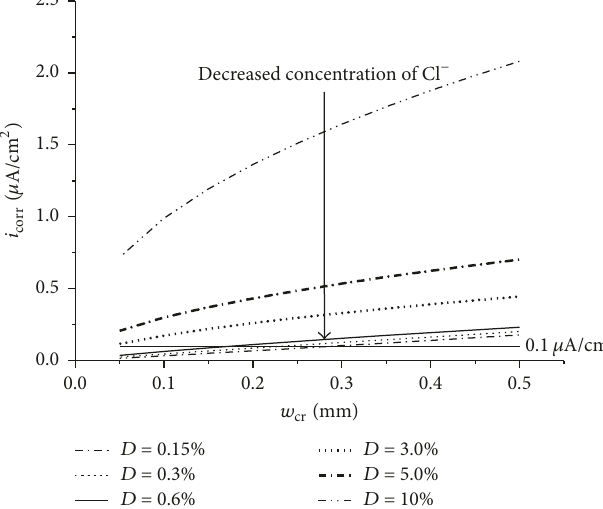
Decreased concentration of ＃Ｆ −